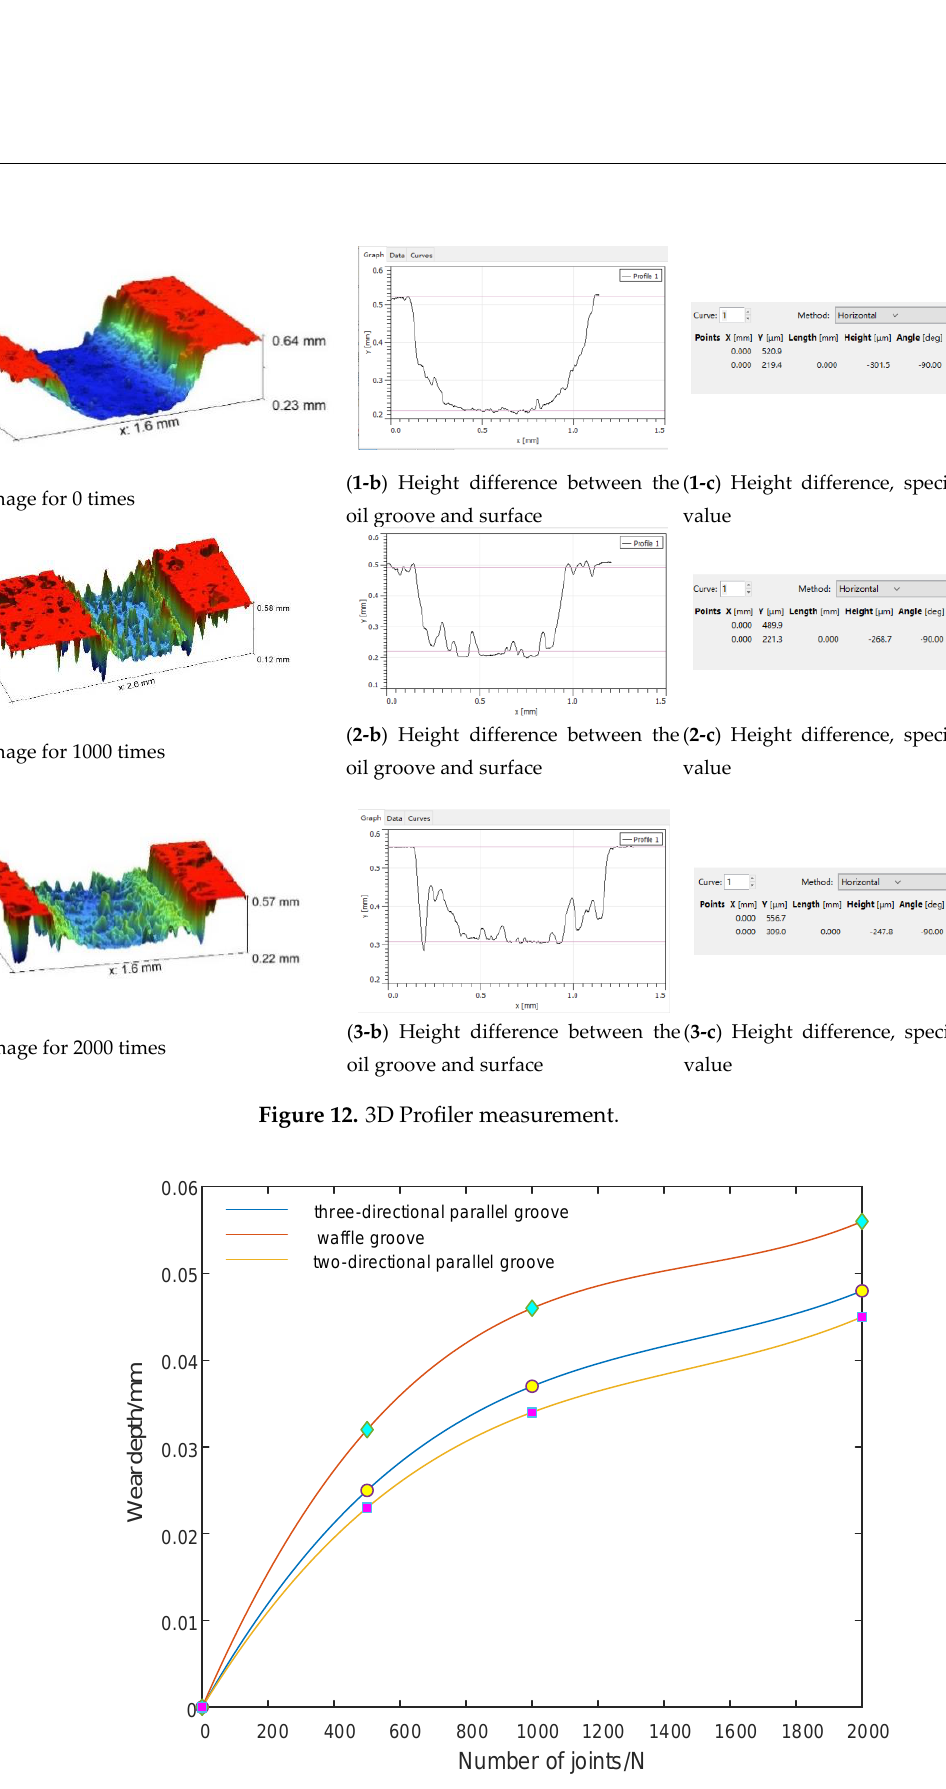
Figure 13. The relationship between the wear depth of the three shapes of grooves and the engage- ment.